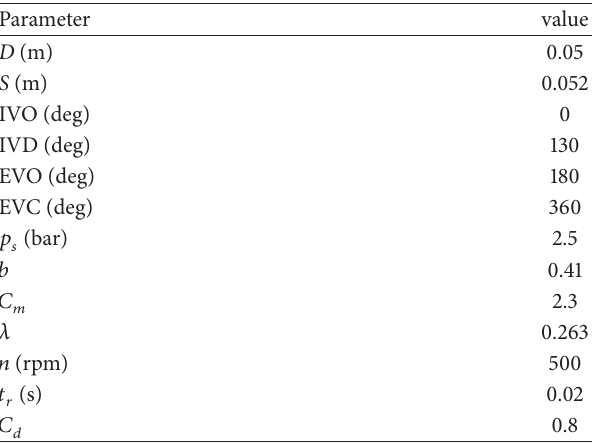
Table 1: Initial value of the